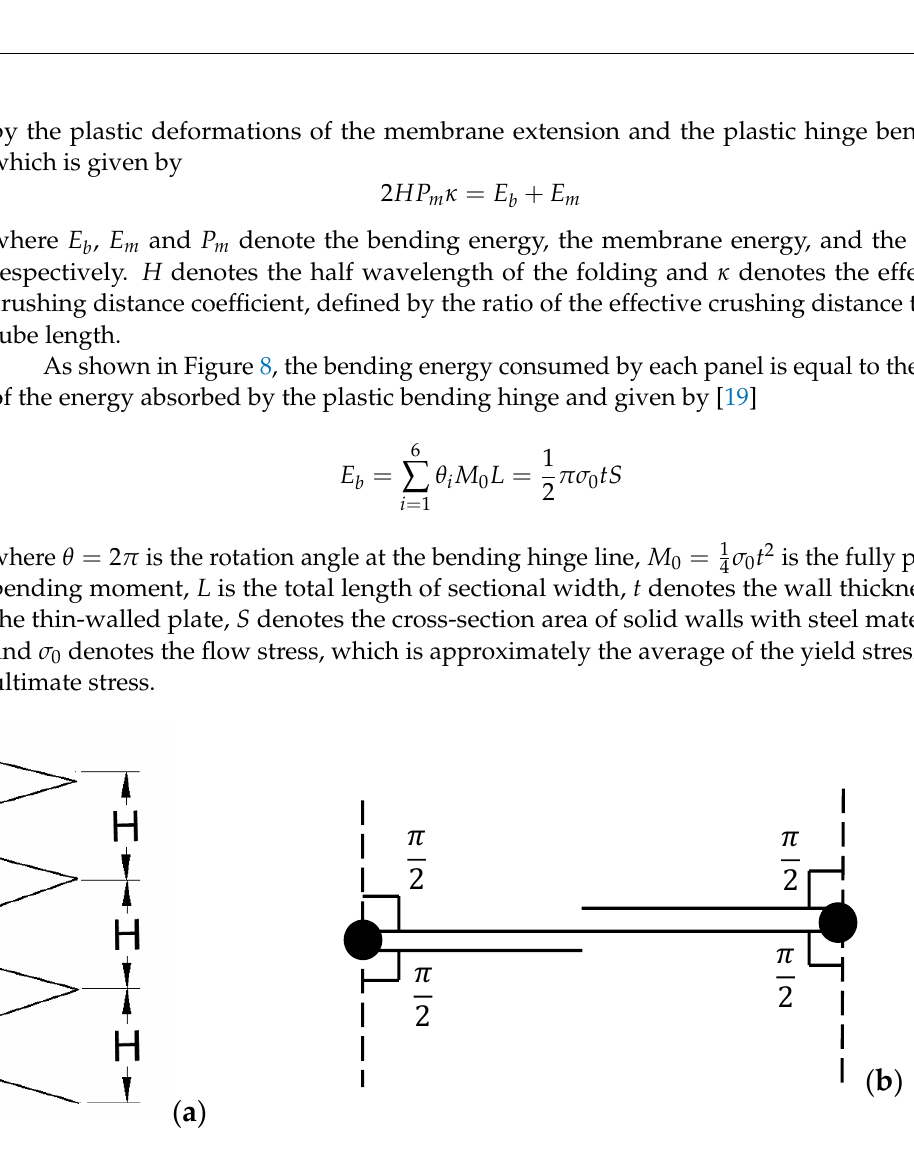
Figure 8. Plastic models of part folding: ( a ) cell folding and ( b ) bending hinge.